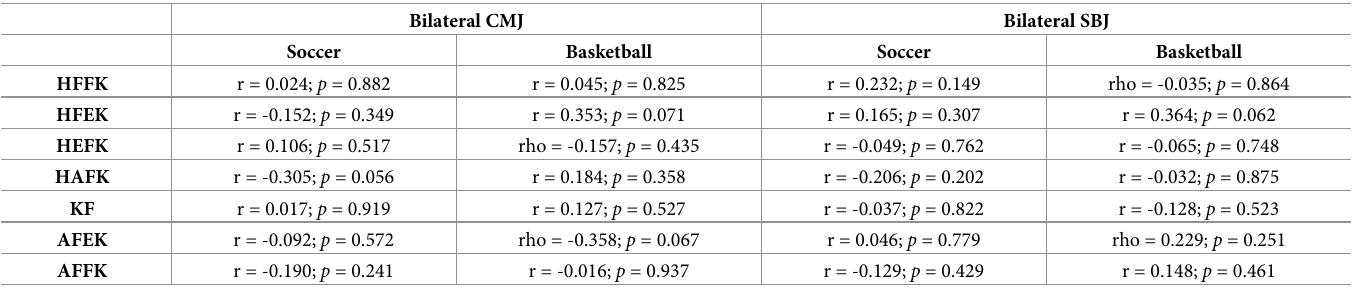
Table 3. Results obtained for the associations between ratio of ROM (ROM_D/ROM_ND) and bilateral jump performance for CMJ and SBJ. respectively. Bilateral CMJ Bilateral SBJ Soccer Basketball Soccer